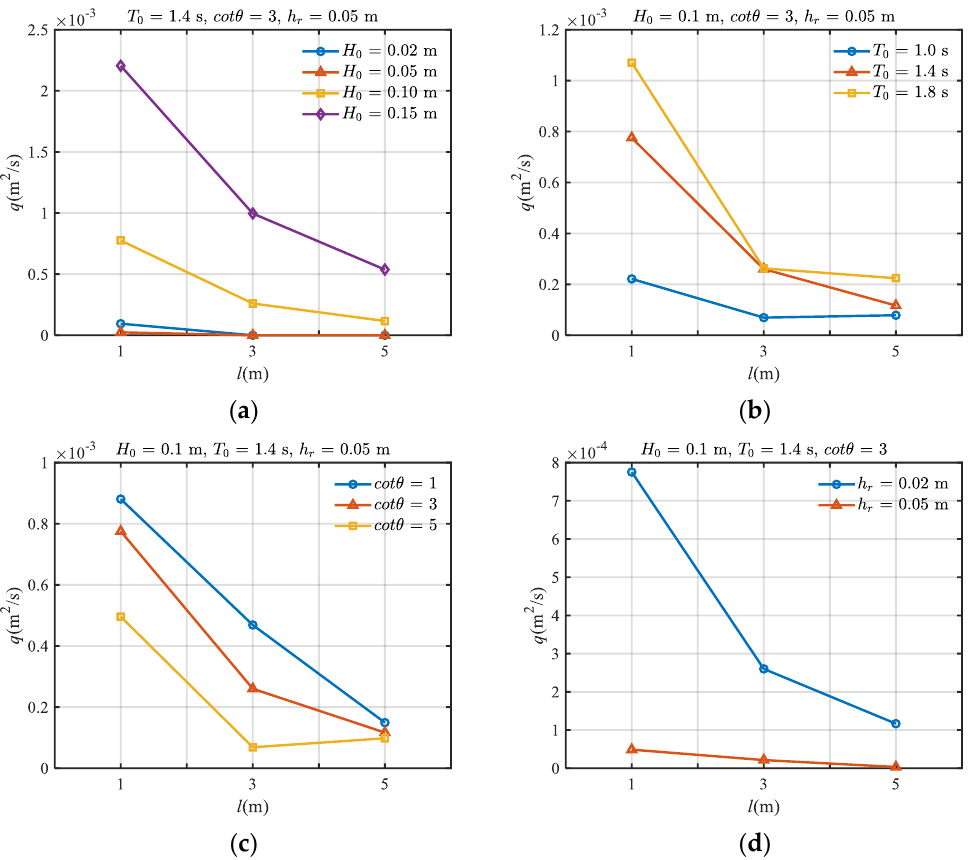
Figure 22. Regular mean wave overtopping discharge over the sloped seawall for different cases: ( a ) H 0 ; ( b ) T 0 ; ( c ) cot θ ; ( d ) h r .